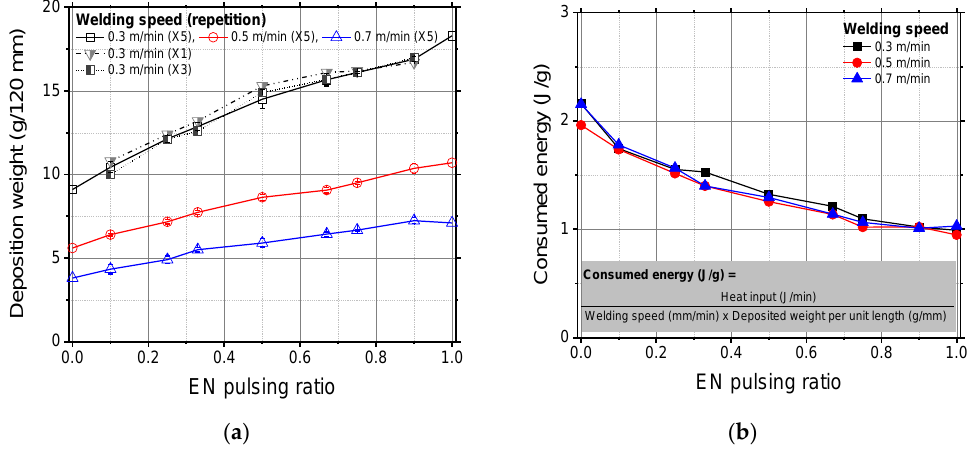
Figure 12. ( a ) Weight of deposited materials per 120 mm of weld length and ( b ) amount of energy consumed by additive deposition process as functions of the EN pulsing ratio.